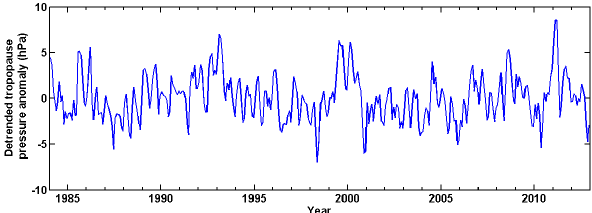
Fig. 2. Deseasonalized and detrended tropopause pressure time se- ries in the January 1984 to December 2012 time frame. The mean tropopause pressure is 103.3hPa, with a 95% CI of ± 0.3hPa (un- certainties hereafter are 95% CI unless noted otherwise). There is a temporal trend towards a lower tropopause pressure (higher tropopause height): − 2.9 ( ± 0.9) hPa over 29 years, consistent with a previous estimate of tropopause height trend (1980–2004) based on simulations (Lamarque and Solomon, 2010). The standard devi- ation of d p trop is 2.5hPa and represents the magnitude of a typical anomaly shown